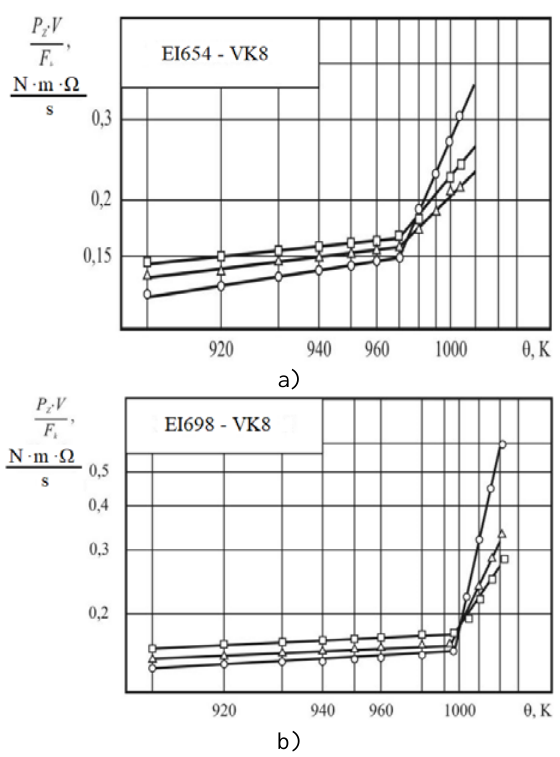
Fig. 3. Dependence of power and electrophysical parameters, speed versus cutting temperature for non-stationary